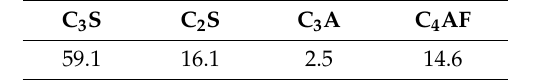
Table 3. Average chemical compound composition of type V Portland cement (%).